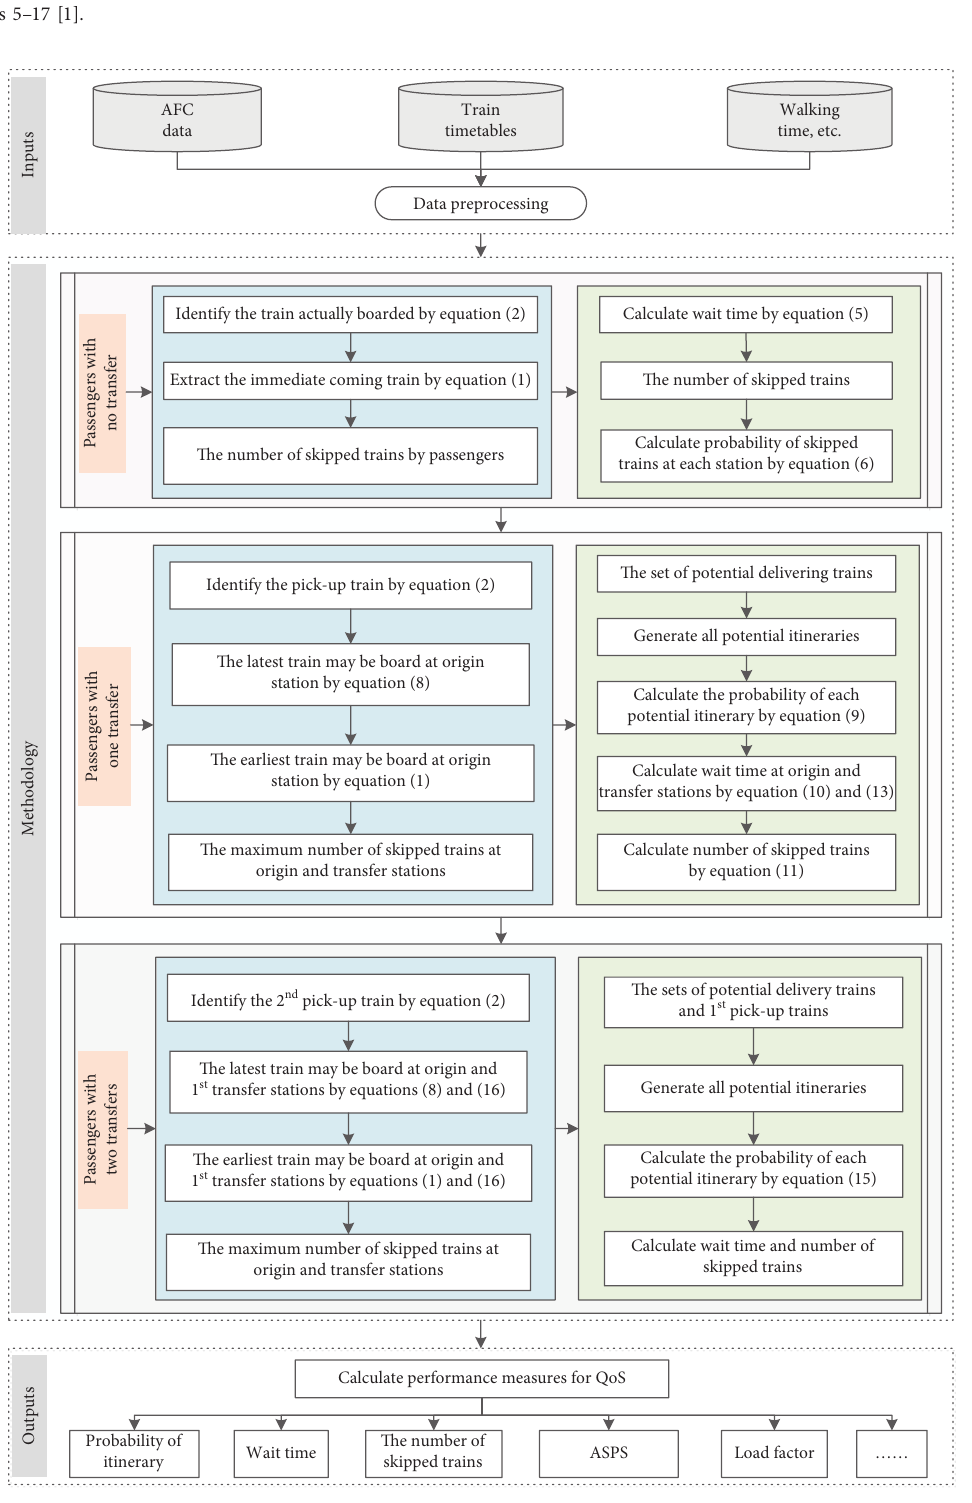
Figure 2: Framework of data-driven approach.